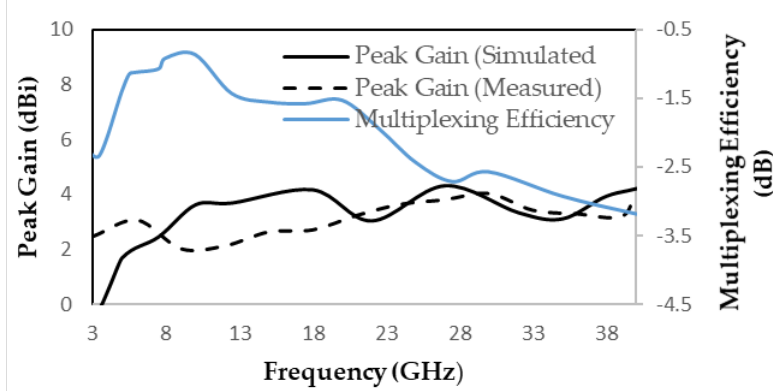
Figure 10. Multiplexing efficiency and peak gain of proposed MIMO antenna.